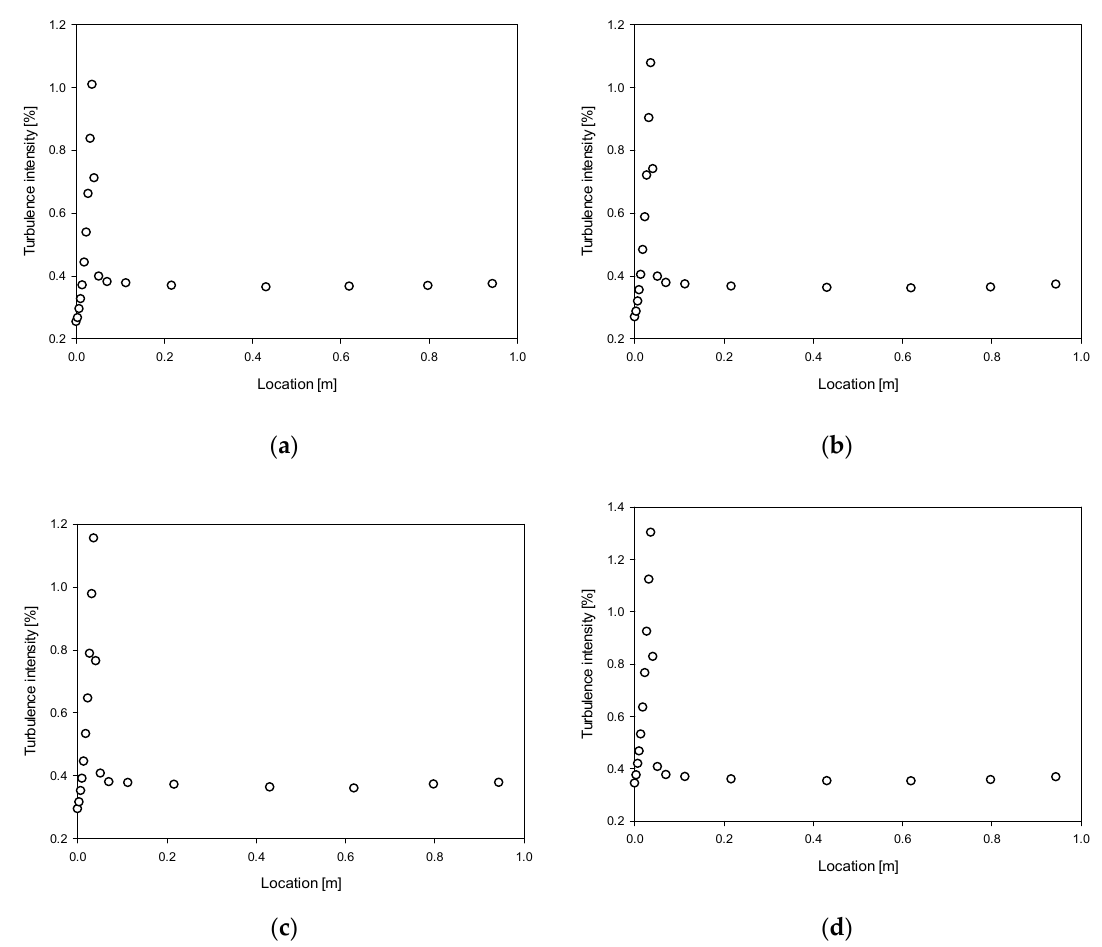
ε− model at different times: ( a ) 150 s,